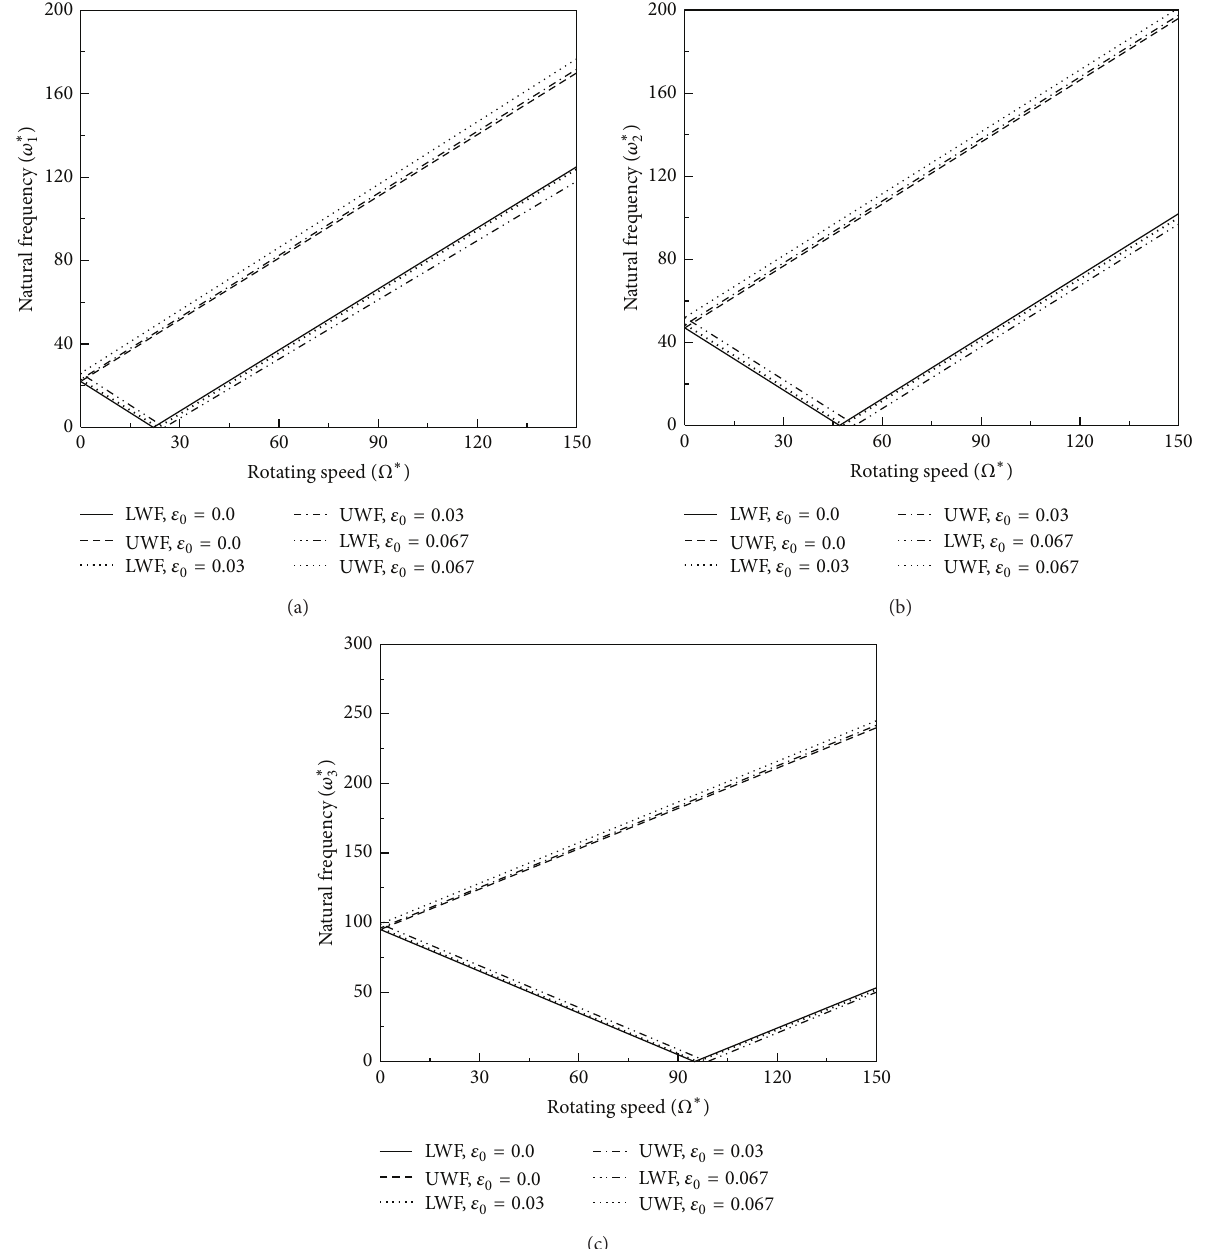
Figure 6: The first three natural frequencies versus rotating speed for the different initial strains of SMA wire ( 𝜃 = 30 ∘ ; 𝑇 = 50 ∘ C; 𝑉 𝑠 = 0.36 ).